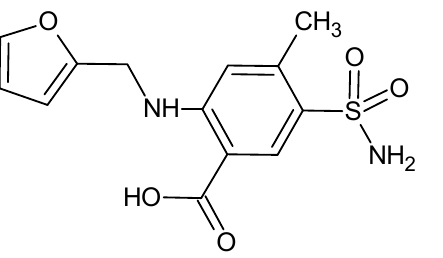
Figure 2. Structural formula of furosemide (FUR) (ChemSketch 12.1.0.31258).